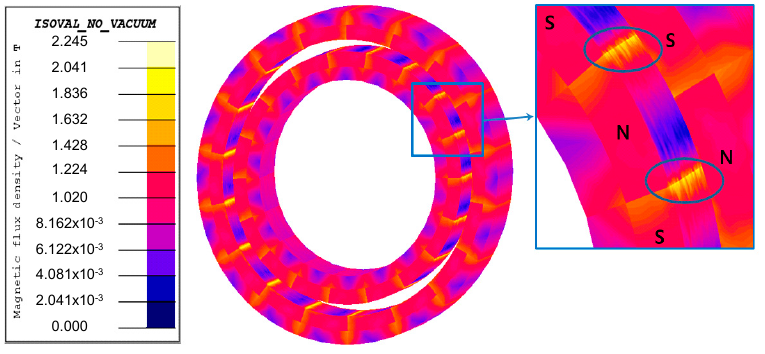
Figure 18. Leakage of magnetic field.